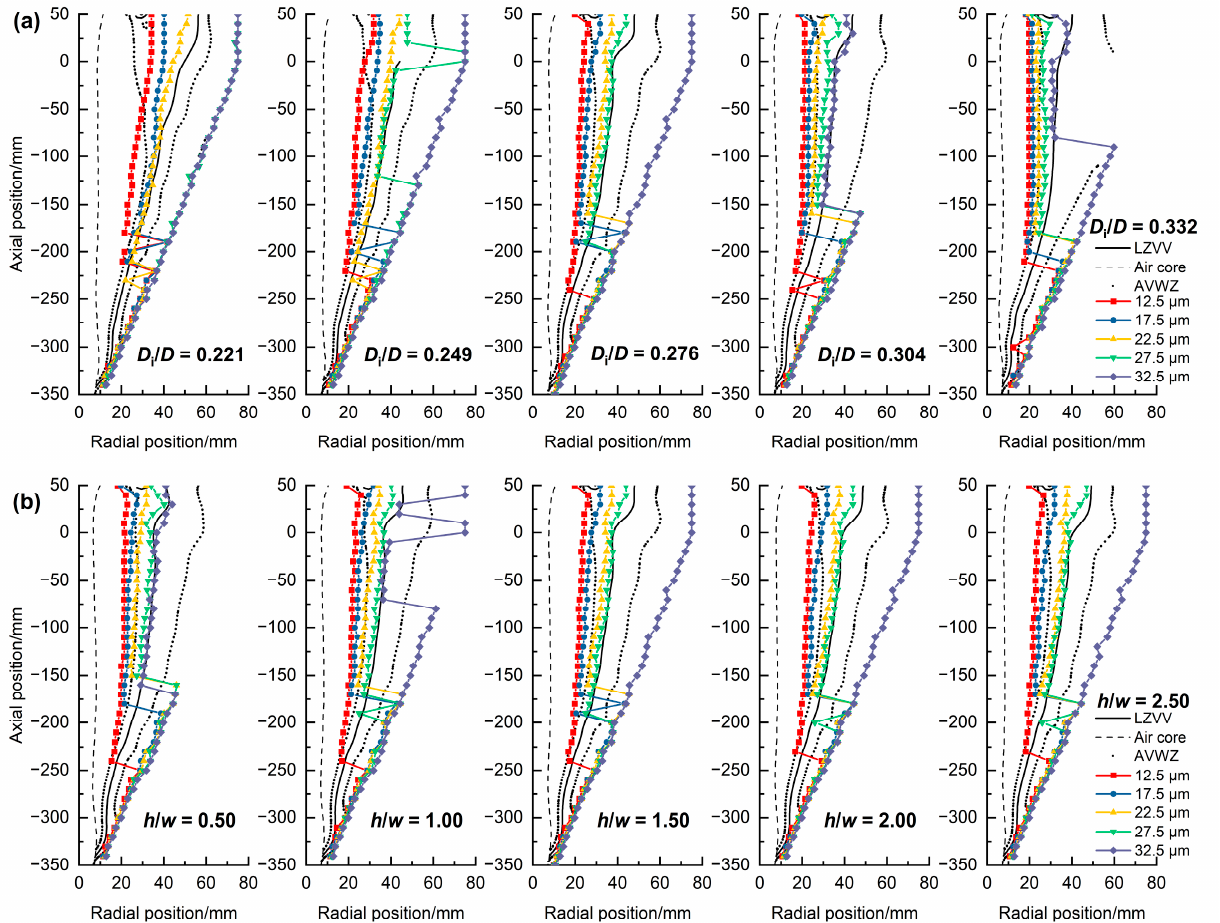
Figure 13. Effects of inlet structure on the equilibrium radius of intermediate-sized particles. ( a )- D i /D; ( b